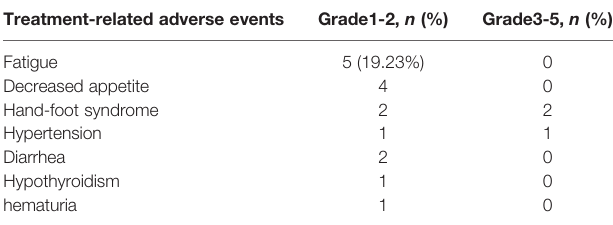
TABLE 4 | Toxicity pro fi le and safety summary. Treatment-related adverse